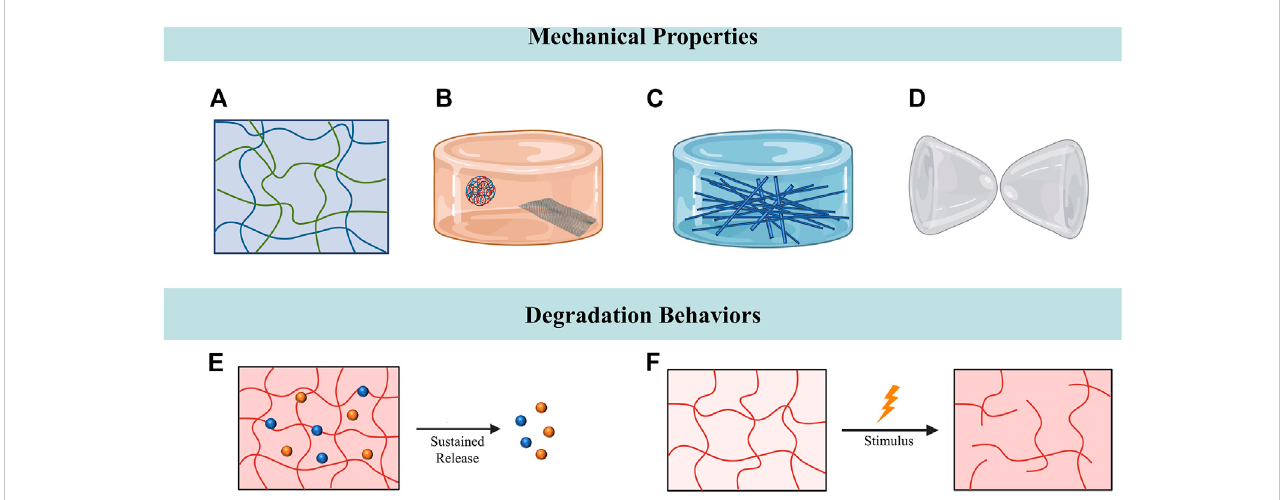
FIGURE 3 Tuning mechanical properties and degradation behaviors for tendon repair. (A) Interpenetrating hydrogels composed of two polymer networks with enhanced mechanical stability. (B) Nanocomposite hydrogels comprised hydrogel and nanometre-sized fi llers. (C) Impregnating the fi brous constructs with hydrogels to fabricate fi ber-reinforced hydrogels. (D) Hydrogels with self-healing properties could maintain intact structures after being ruptured. (E) Hydrogel-based sustained release system. (F) The degradation of responsive hydrogels could be manipulated by